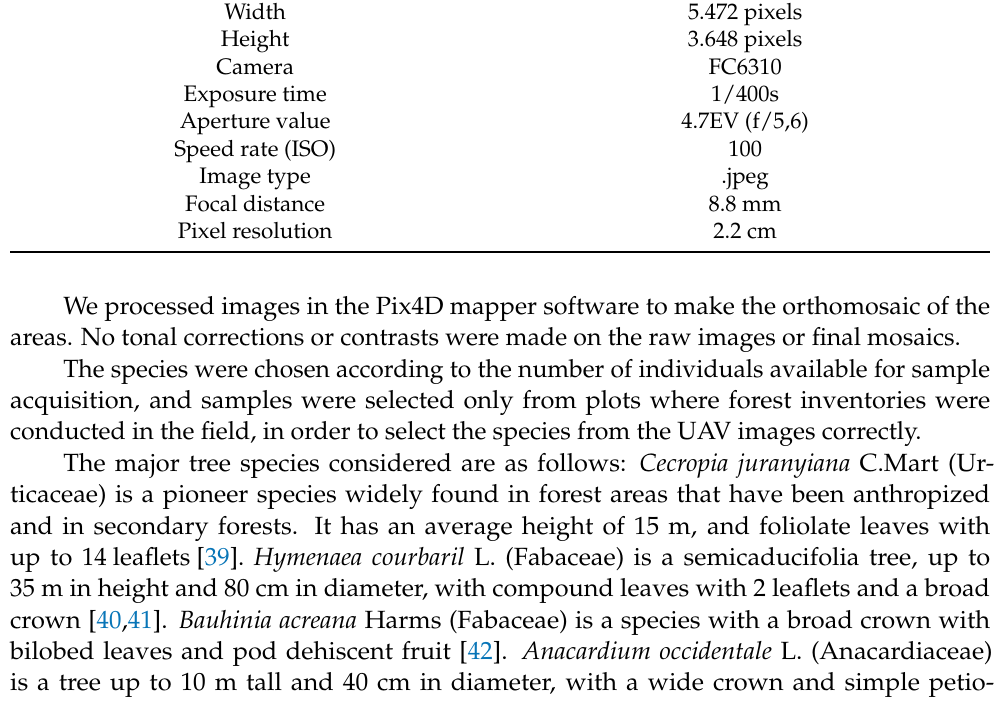
Table 1. Characteristics of images obtained from the UAV DJI PHANTOM 4 PRO.